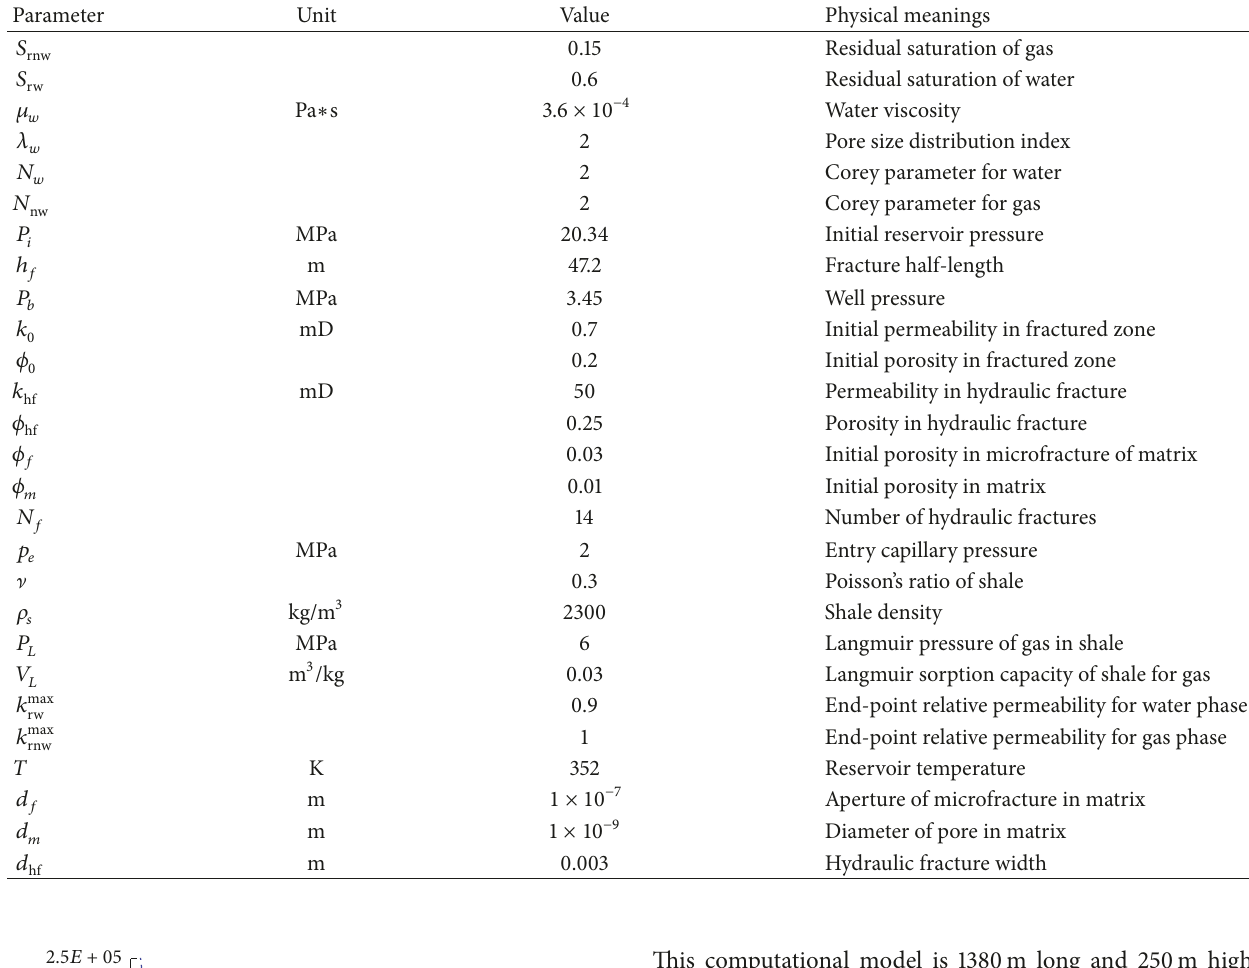
Table 1: Model parameters for Barnett shales.